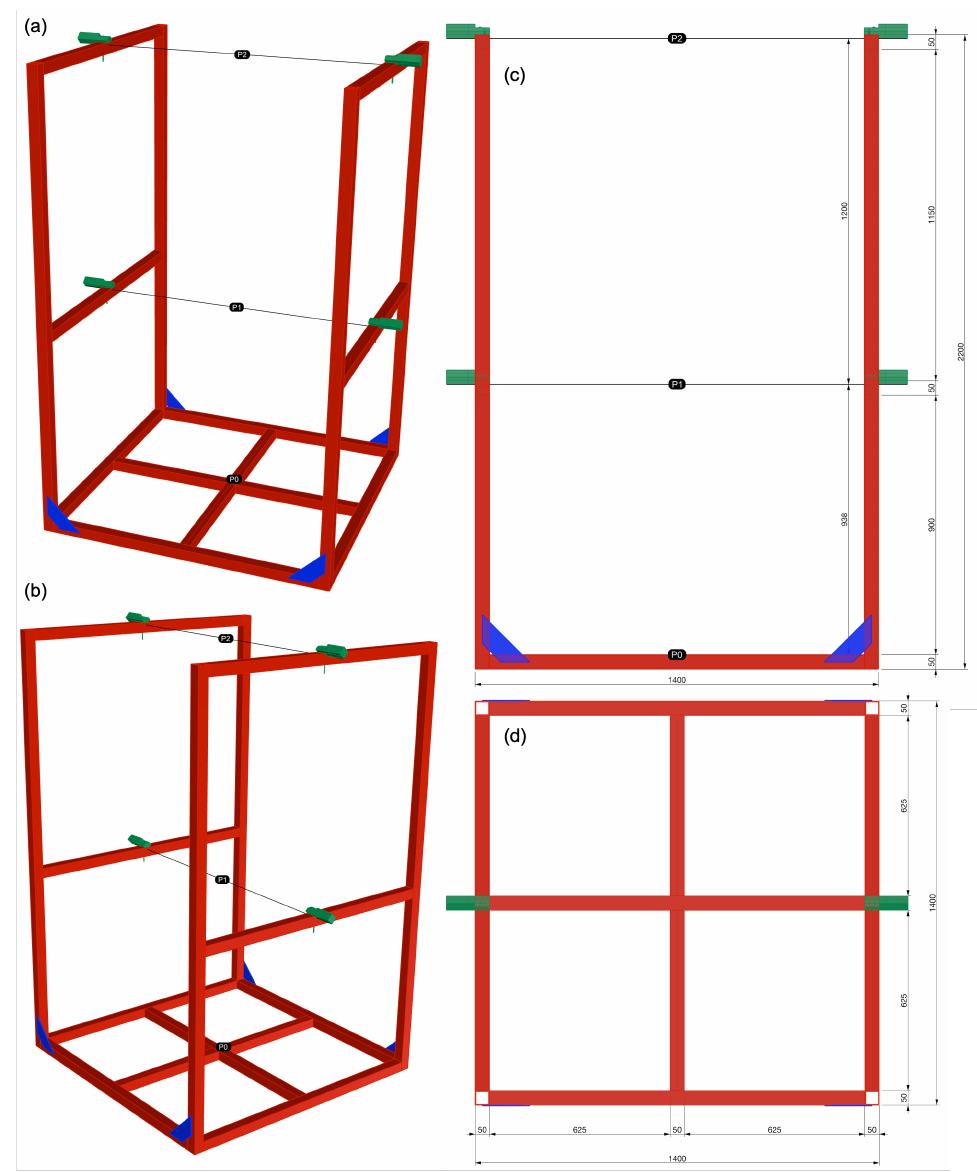
Figure 2. Drawing of the swing (all length in mm) and different pivot axis and reverences heights P0, P1 and P2: ( a , b ) Axonometric projection and overview. ( c ) Front view and ( d ) top view including